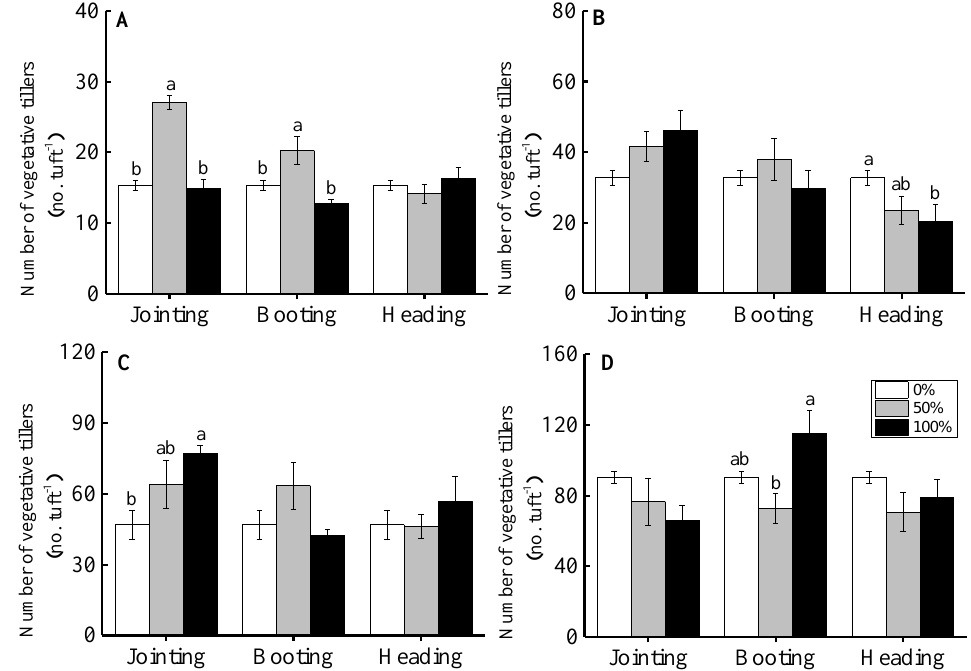
Figure 2. The effect of clipping intensity on the number of vegetative tillers of H. brevisubulatum of different grades when clipped at the jointing, booting, and heading periods. A , B , C , and D represent the grades (1, 2, 3, and 4, respectively) of the tuft diameters of H. brevisubulatum . Different lowercase letters represent significant differences among different clipping intensities ( p < 0.05).